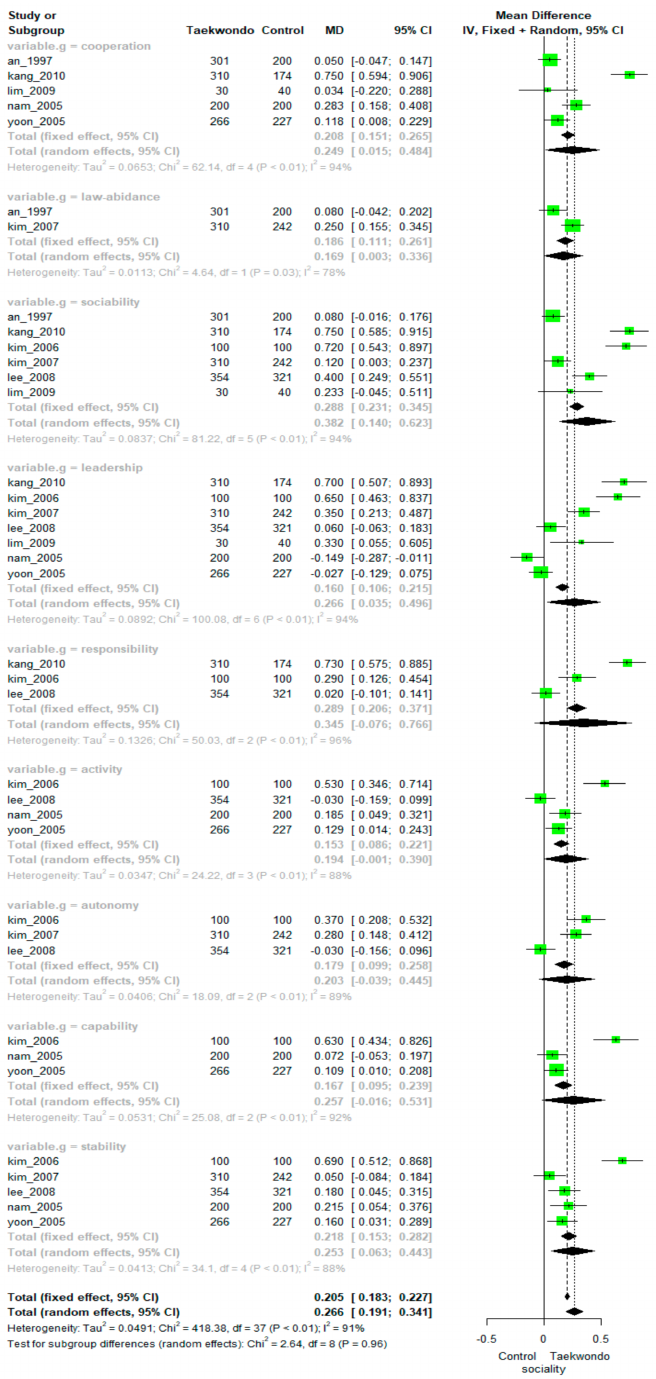
Figure 2. Forest plot of Taekwondo effects on